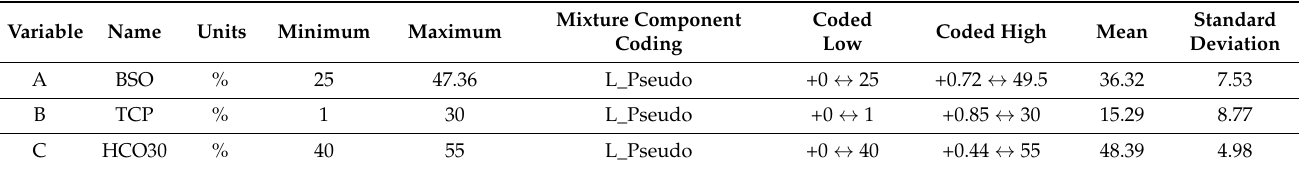
Table 8. The design variables’ constraints and